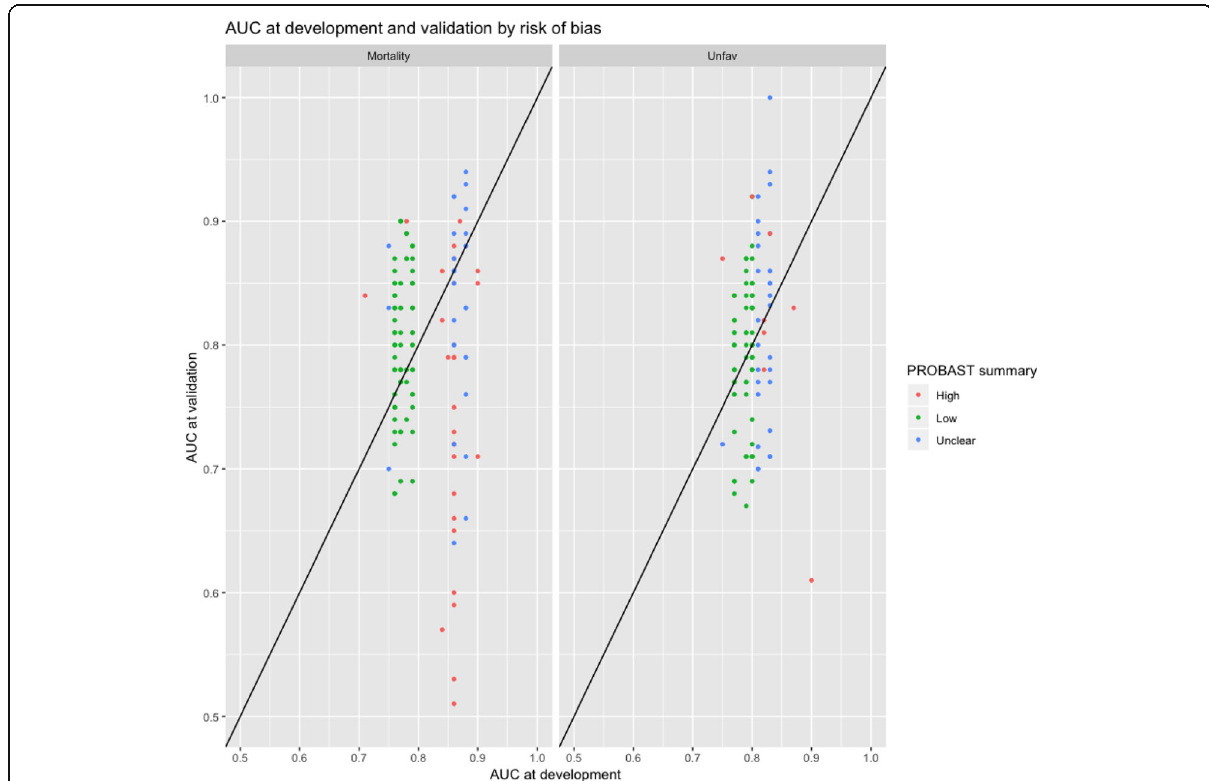
Fig. 2 AUC of 18 models at development and in 242 validation studies by risk of bias assessed with the